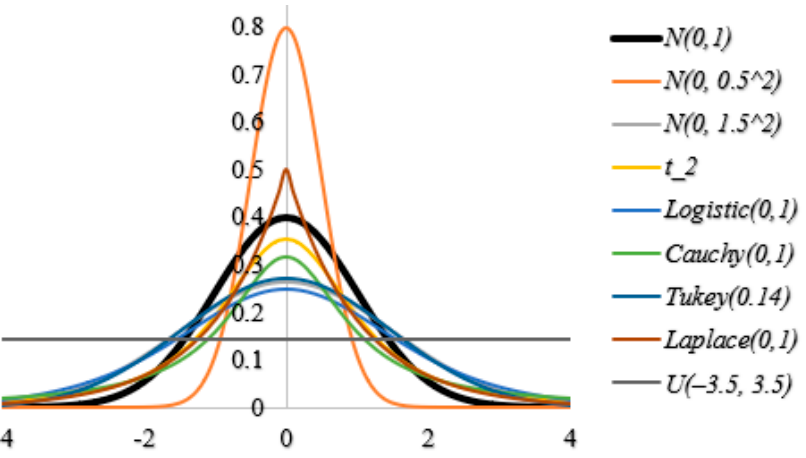
Figure 3. PDFs of symmetric alternative distributions compared to the PDF of null N ( 0,1 ) distribution. Table 2. Empirical powers of statistic V n for symmetric alternative distributions for the level of significance α = 0.05.